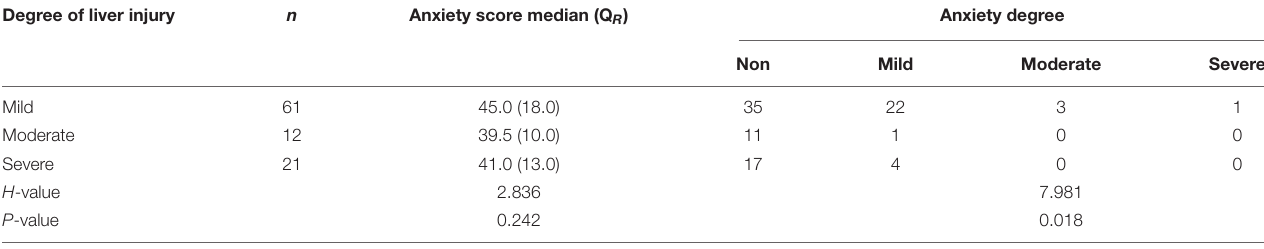
TABLE 3 | Relationship between the degree of liver injury and the degree of anxiety.